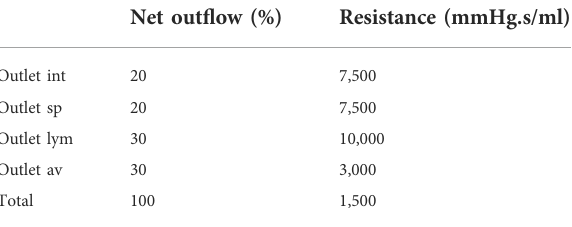
TABLE 2 Overview of resistance values at the four different